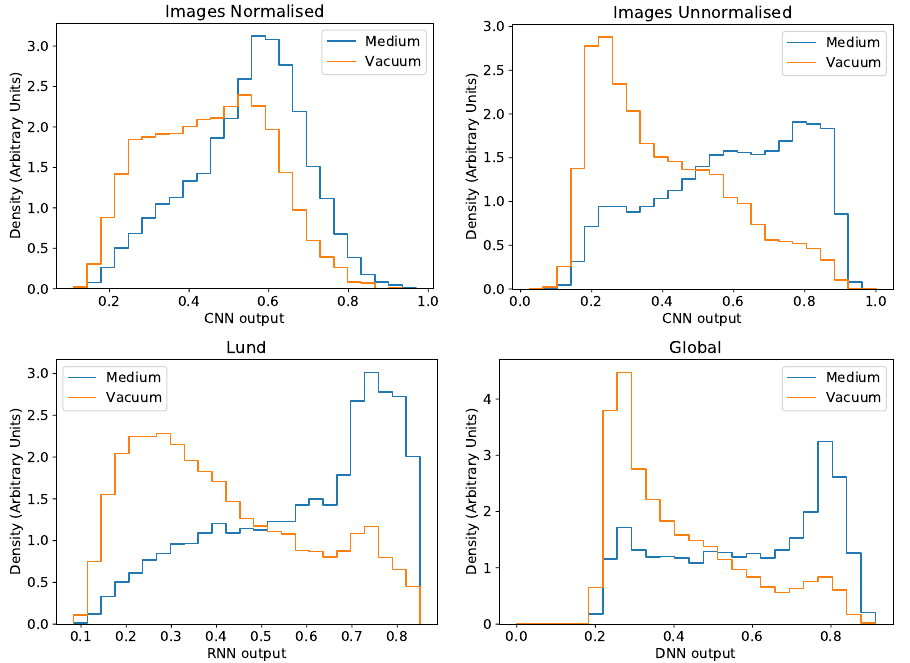
Figure 9 . Distribution of the different Deep Learning outputs for the Vacuum and Medium